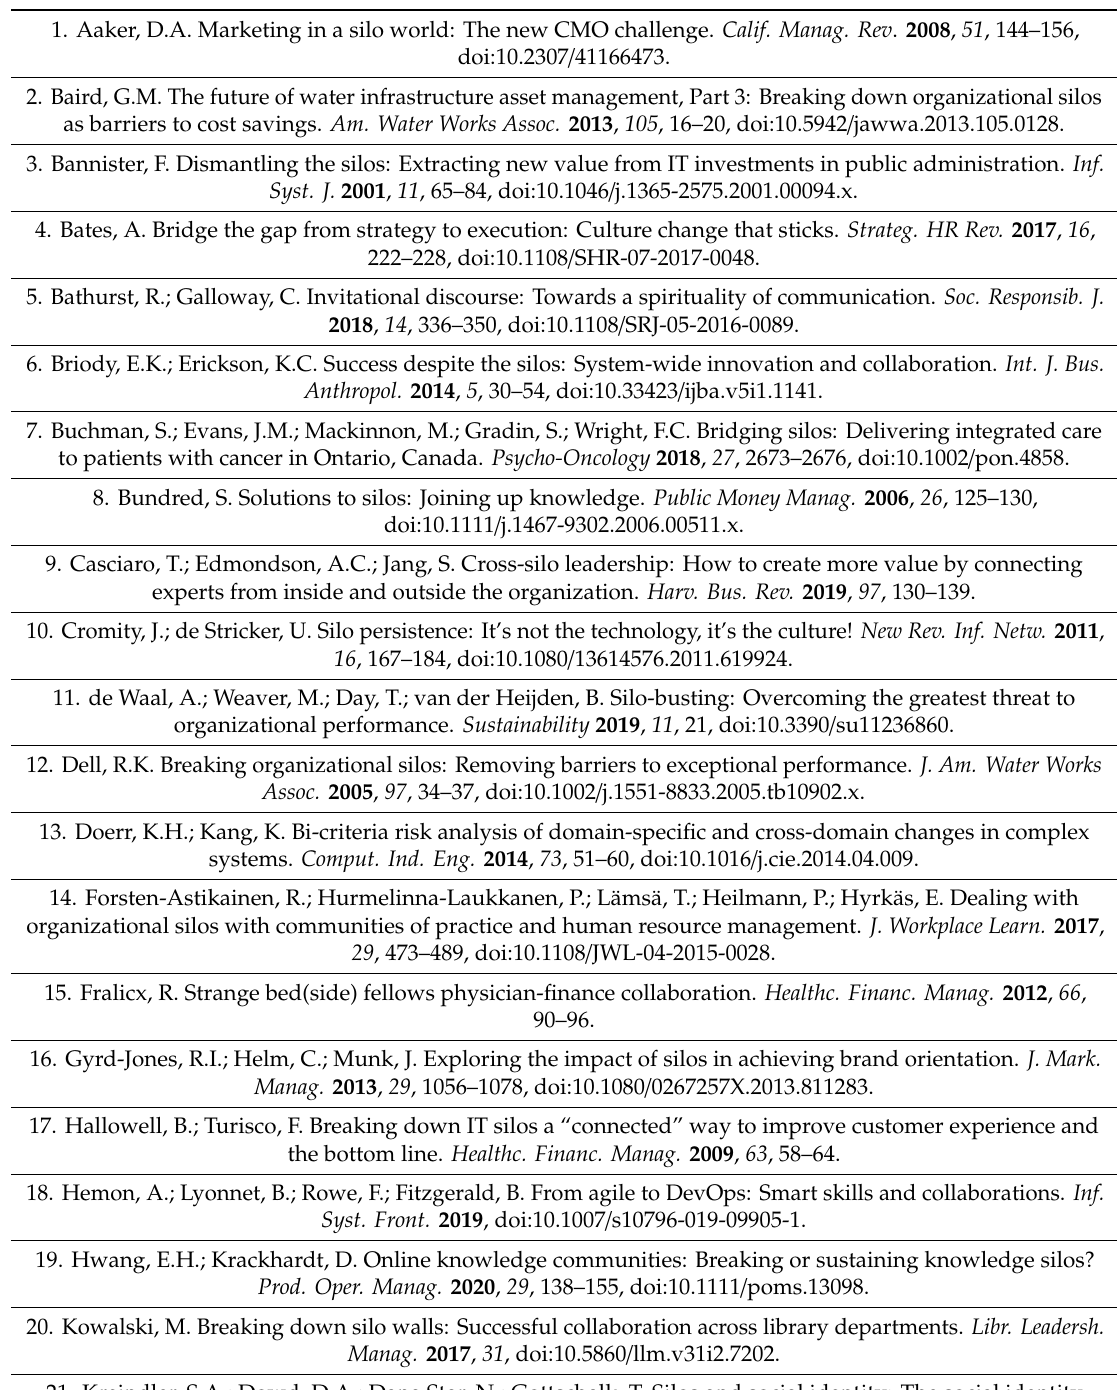
Table A5. Articles included for analysis in the scoping